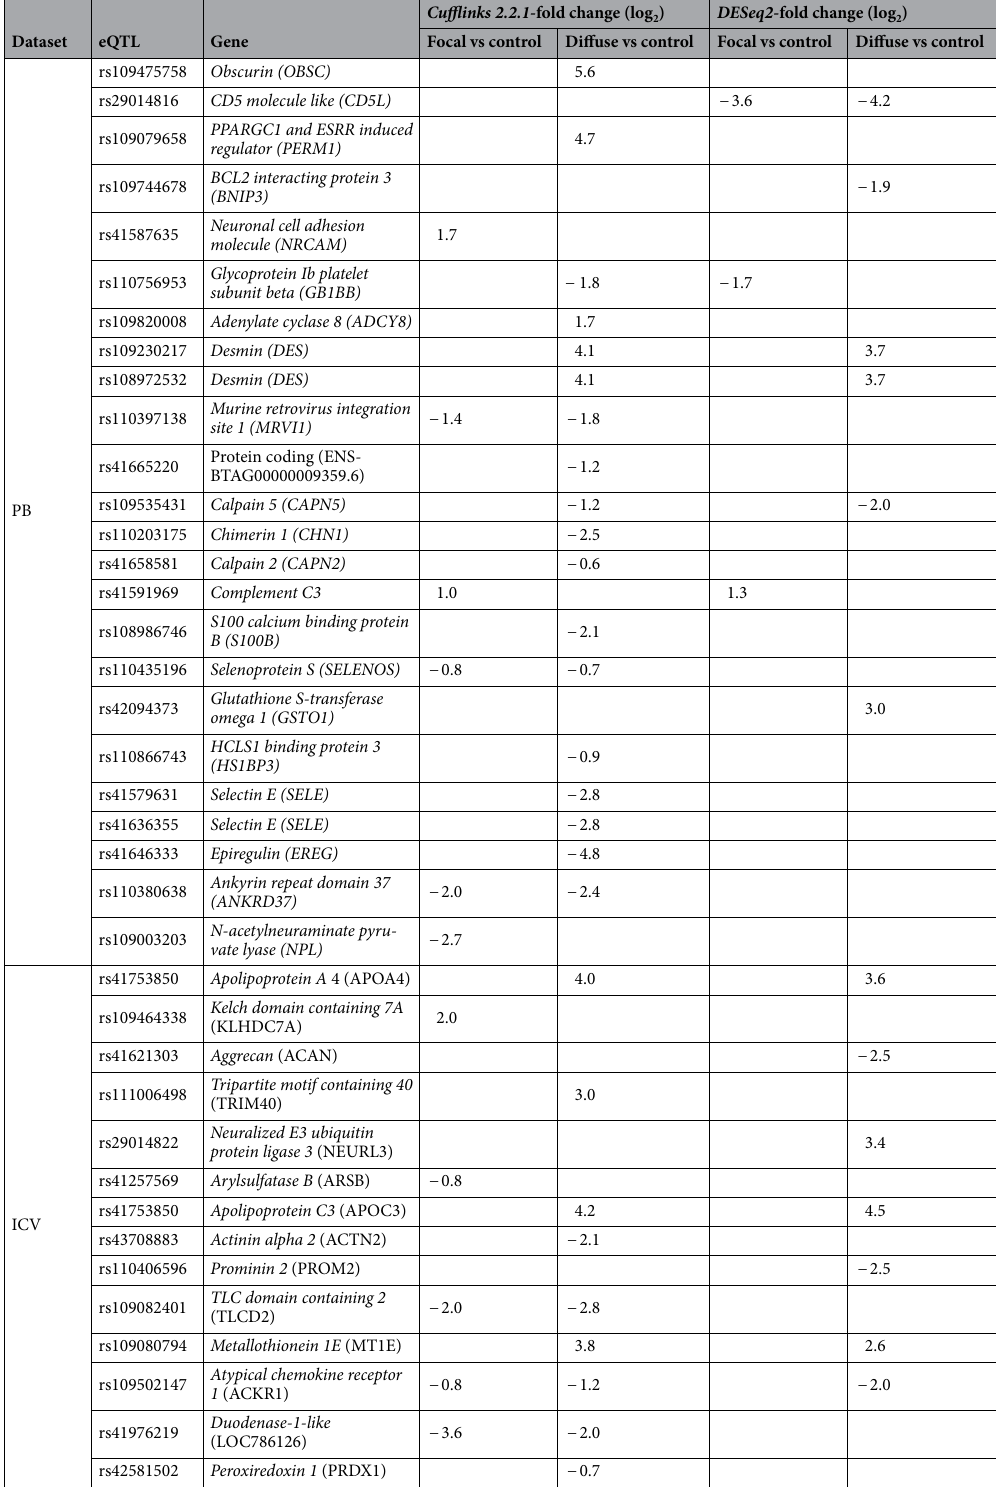
Table 2. Genes with cis-eQTLs that are differentially expressed in response to MAP